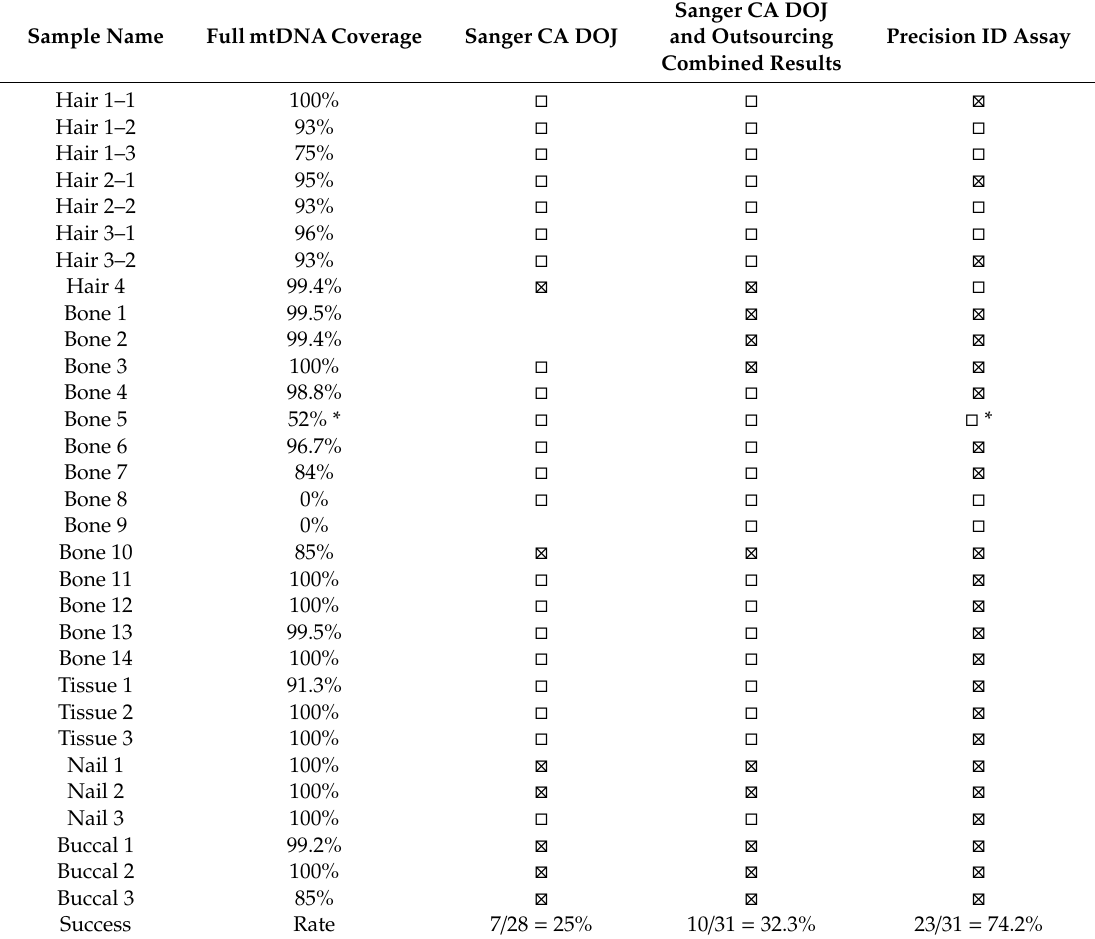
Table 4. Precision ID mtDNA assay success rate. The table shows the sample name, Precision ID result coverage percentage for the full genome, California Department of Justice (CA DOJ) Sanger results, CA DOJ and outsourcing combined Sanger results, the Precision ID assay results and the success rate for each. Success rate is determined based on a full single-source HVI and HVII Sanger result or a full control region massively parallel sequencing (MPS) result. The absence of a box indicates no typing attempt was made, the presence of an uncrossed box ( (cid:3) ) indicates typing was attempted but unsuccessful, and a crossed box ( (cid:2) ) indicates typing was attempted and